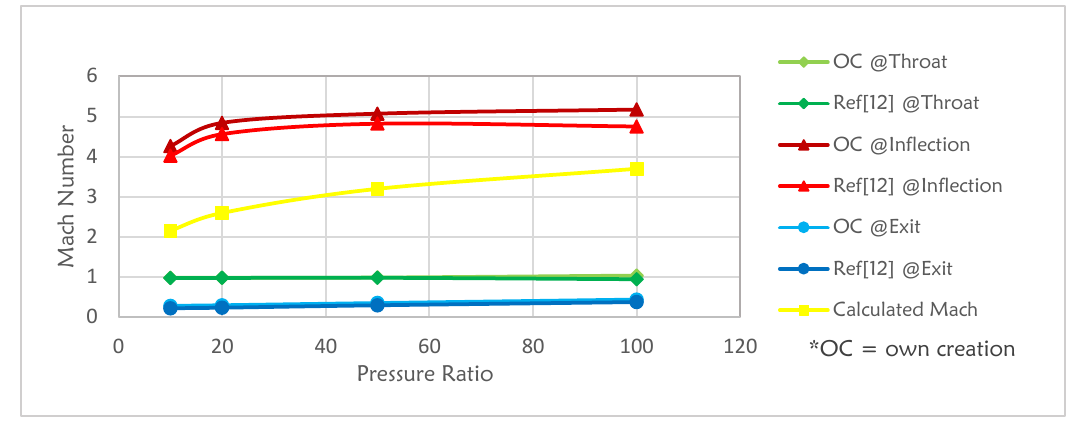
Figure 10: Mach number at different nozzle position (along with centre line) for four different pressure